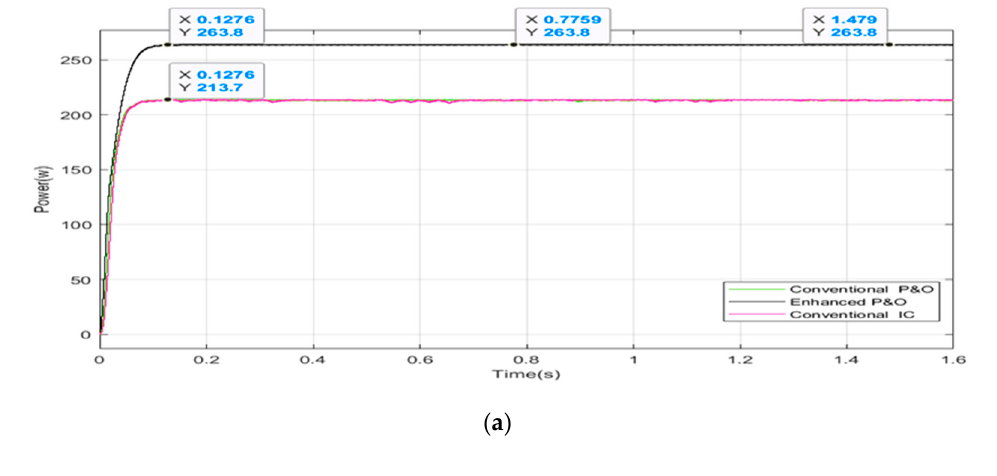
Figure 13. Scenario of Case Four (Strong partial shading pattern)